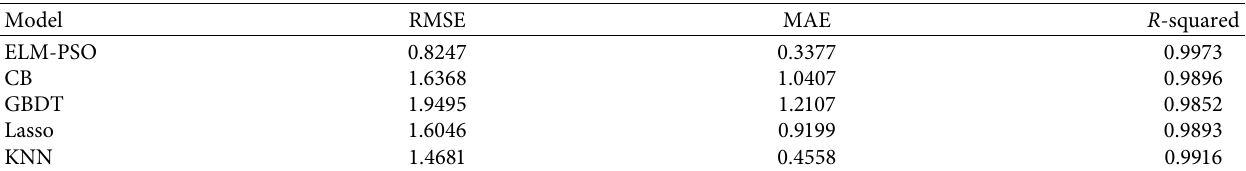
Table 4: Prediction errors on each model’s training set for the W-G HSR